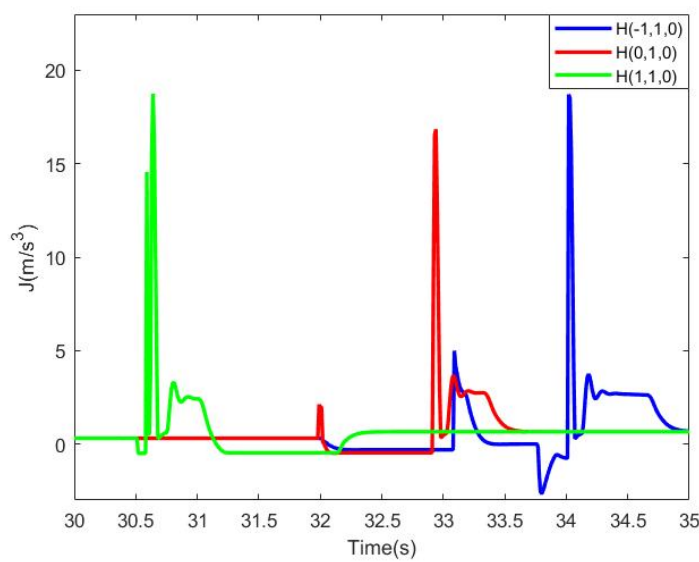
Figure 15. The jerk in uncontrolled strategies ( H = (x,1,0)).